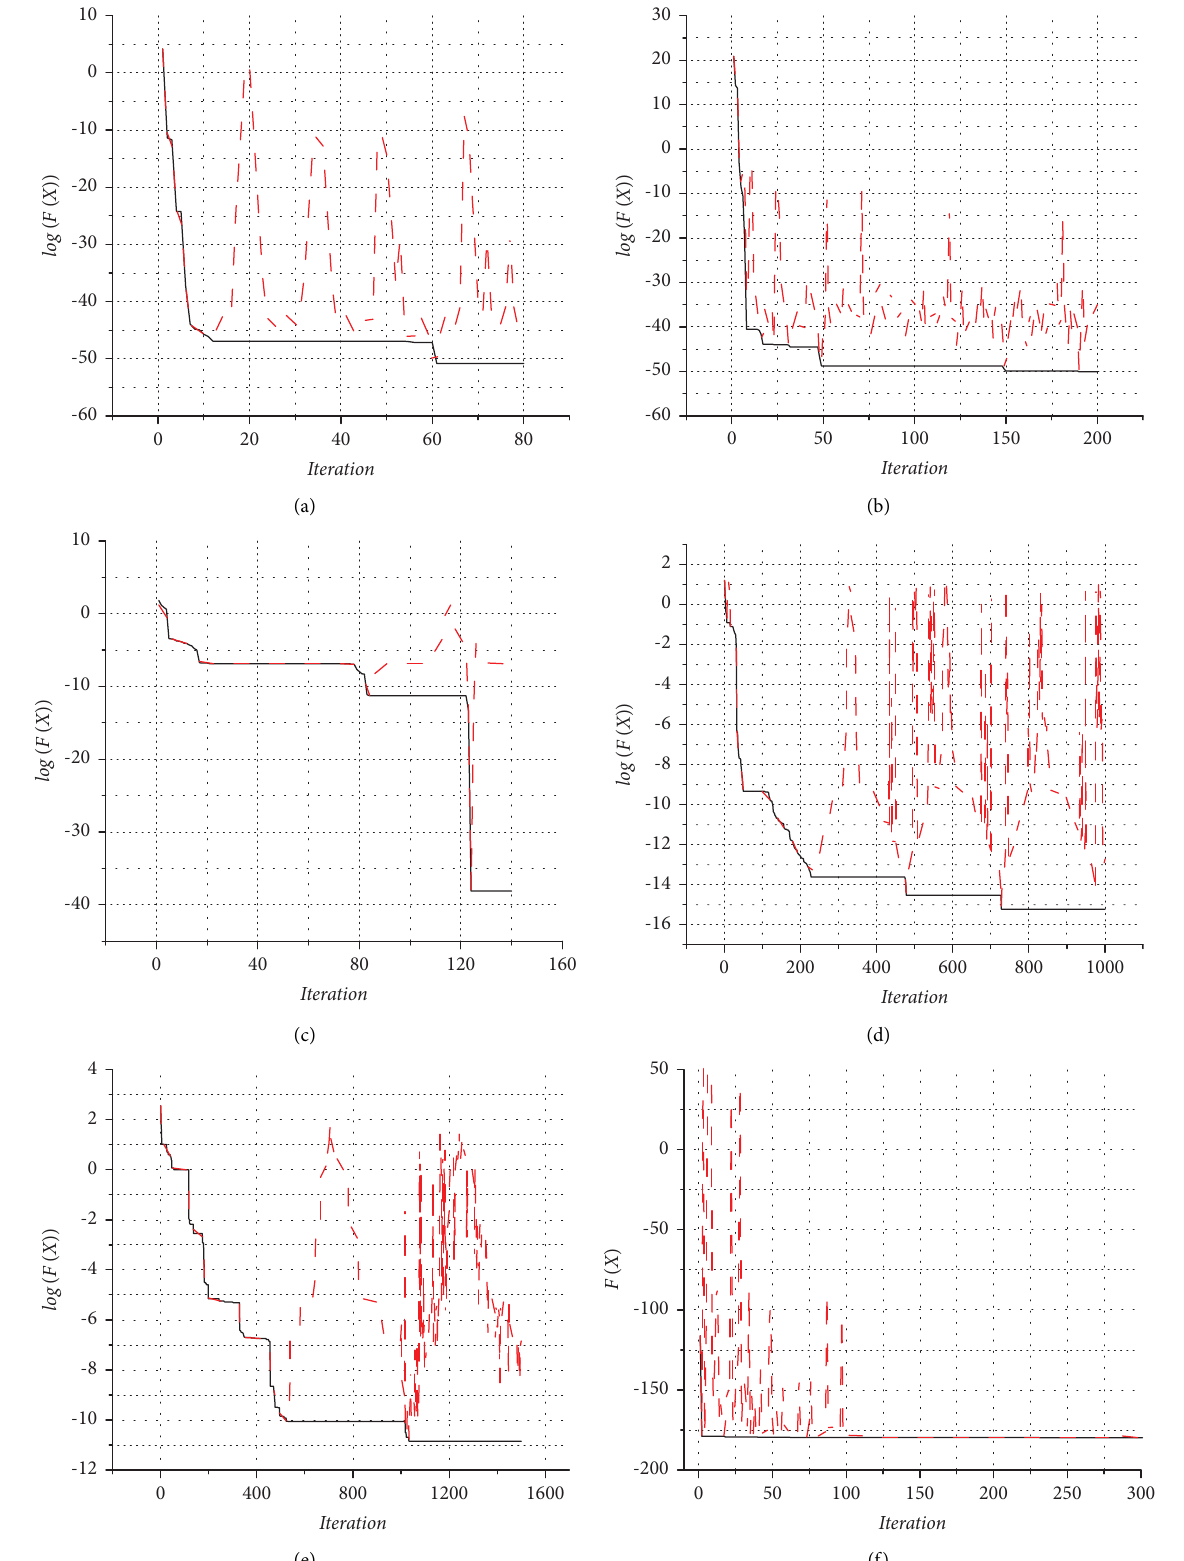
Figure 6: Te variation curve of the best function value in 50 simulations. (a) f